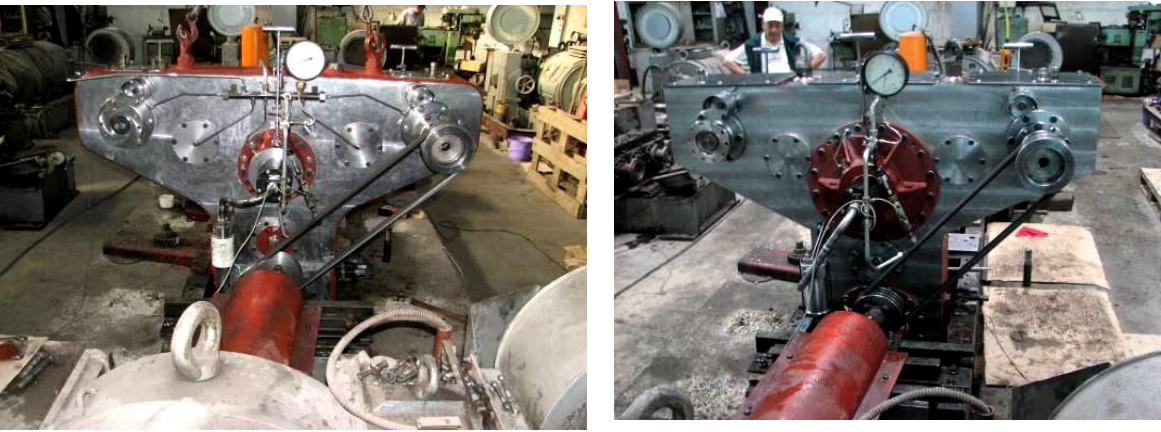
Figure 21. Measured accelerations at points 1 and 2 for the two versions (old and new).